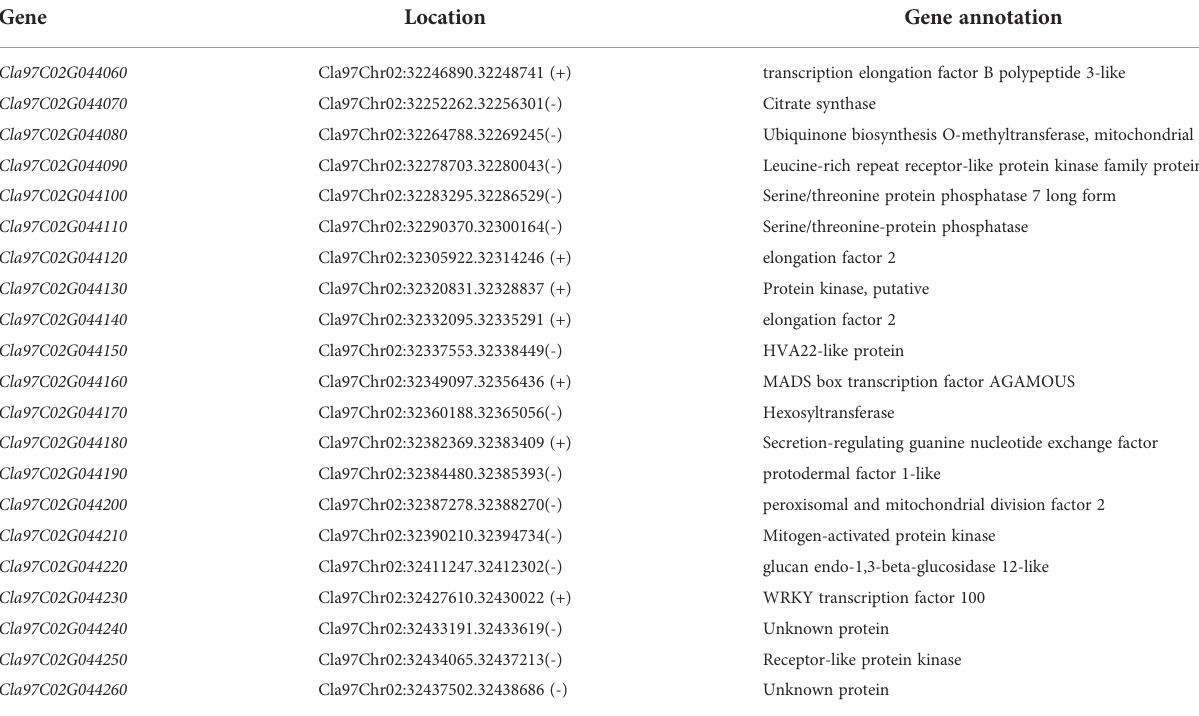
TABLE 2 Candidate gene information of rind thickness and single fruit weight on chromosome 2. Gene